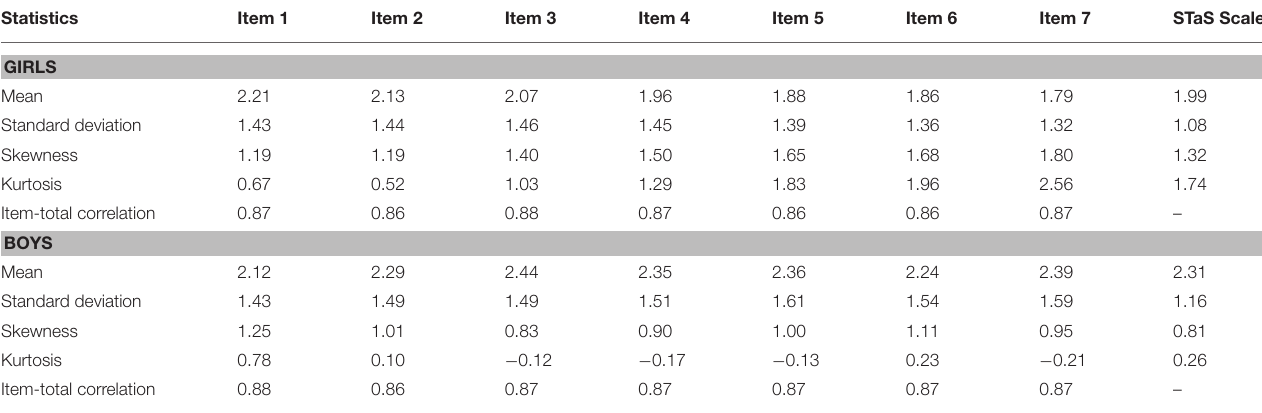
TABLE 2 | Descriptive statistics of the STaS items and the STaS scale in gender groups. Statistics